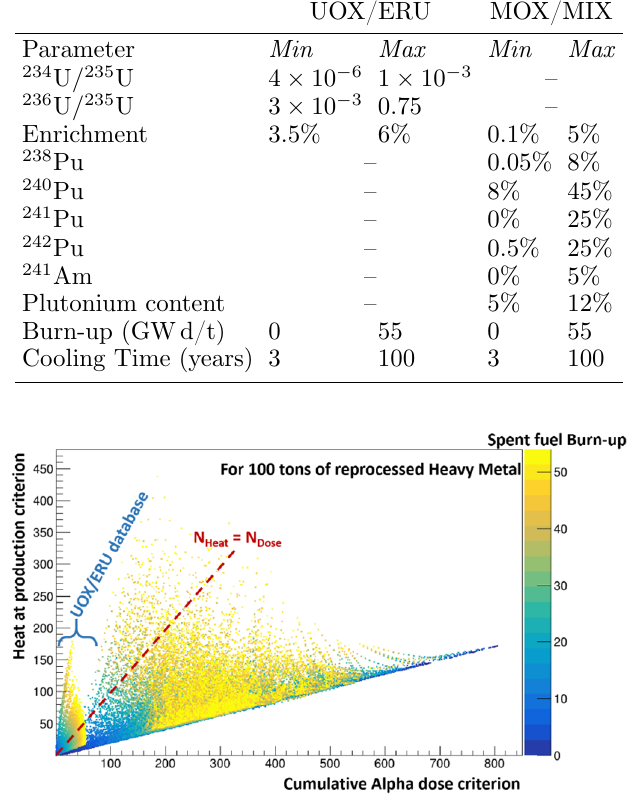
Fig. 3. Number of produced canister, regarding only decay heat or only alpha dose, while reprocessing 100 tons of heavy metal coming from different spent fuels as a function of the reactor burn-up (in GWd/t).